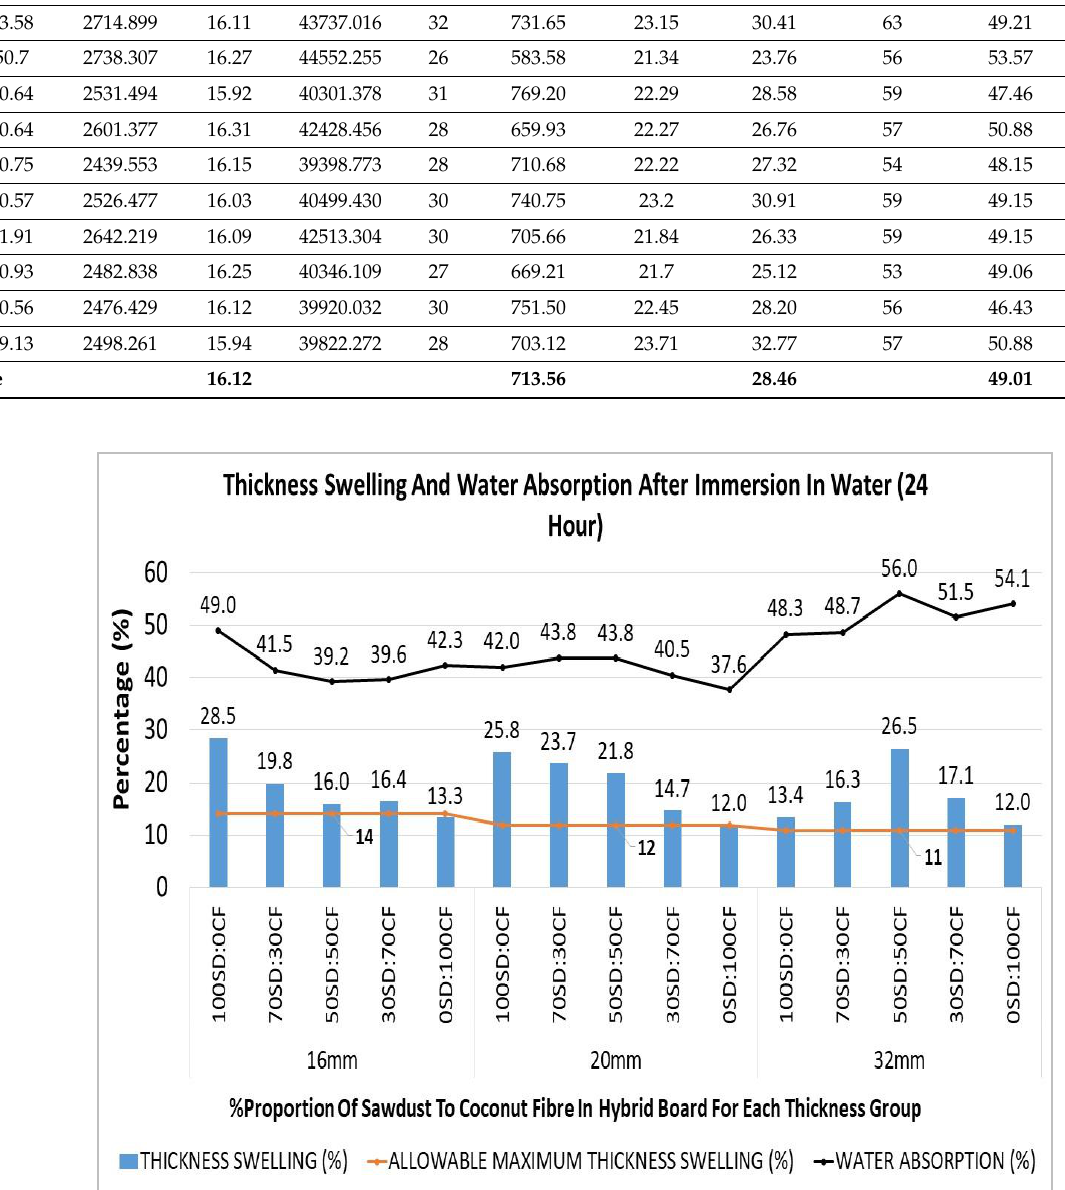
Figure 13. Thickness Swelling and Water Absorption after Immersion in Water (24 h).